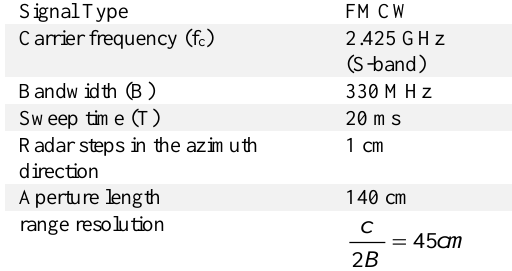
Table 1. GB-SAR main characteristics